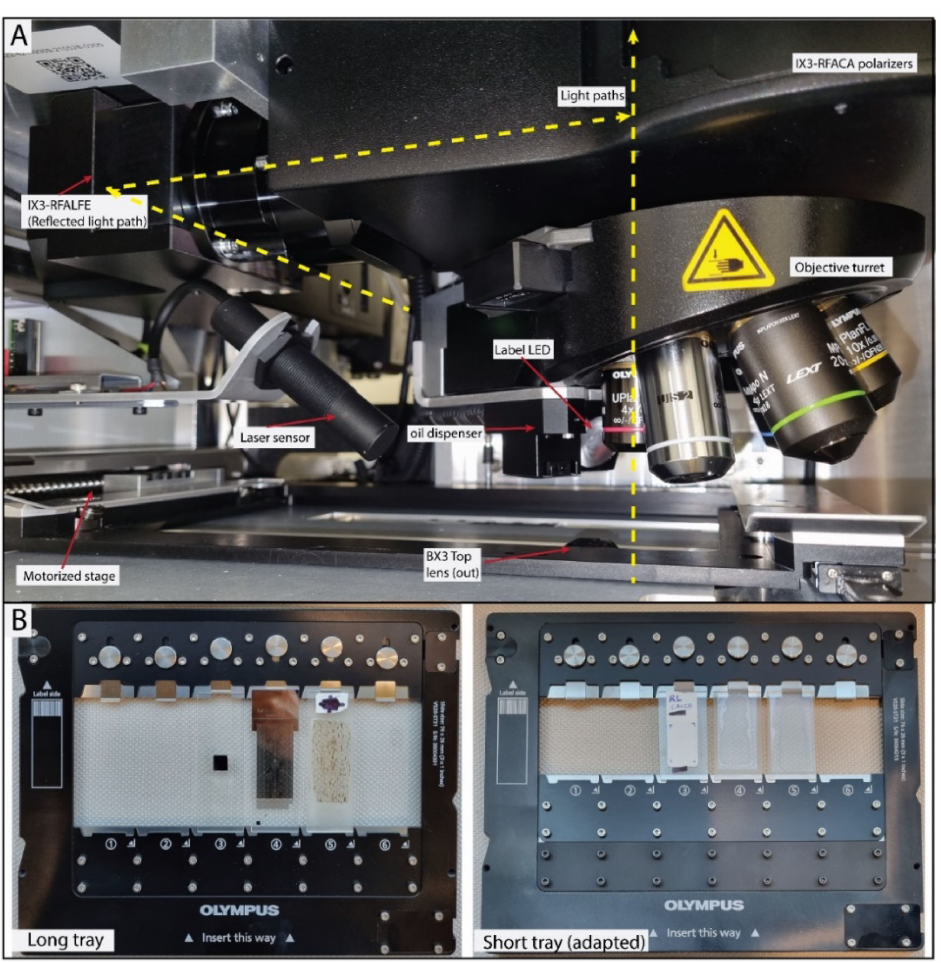
Figure 2. VS200 setup photos. ( A ) Sample chamber without sample tray showing components. The upper half of the optical axis is shown in dashed yellow lines. ( B ) Slide trays with the calibrat- ing samples inserted in the long (pocket #3: Si semi-conductor wafer; 4: vs. calibrating sample; 5: biotite-garnet gneiss) and short (pocket #3: white label; 4 and 5: quartz crystals)